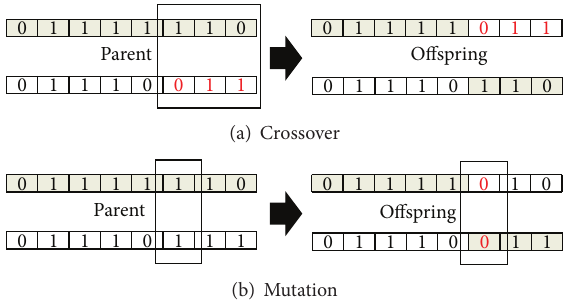
Figure 1: Illustration of crossover and